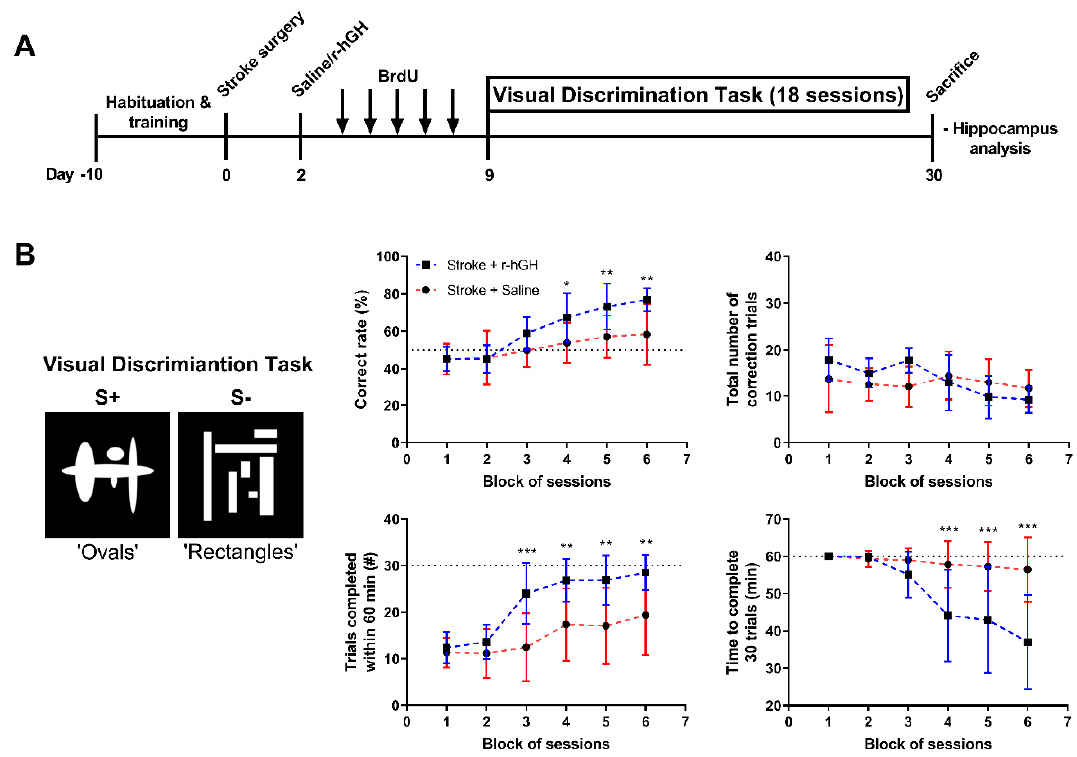
Figure 1. ( A ) Experimental design. ( B ) Illustration of the visual discrimination (VD) task.